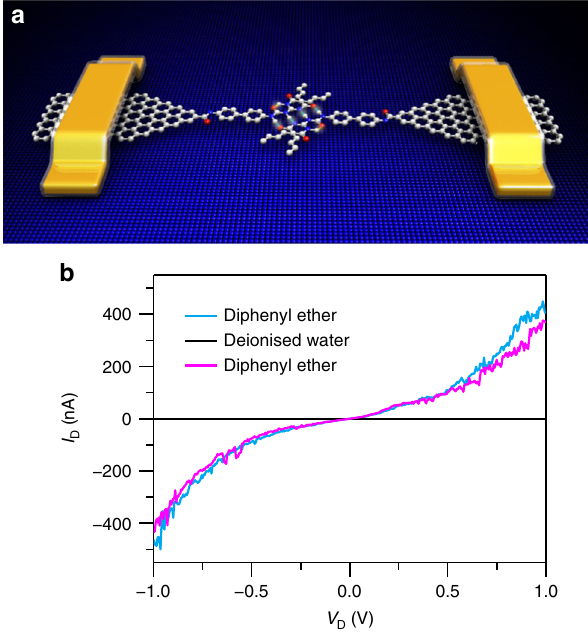
Fig. 1 Device structure and electrical characterisation of HBB-SMJs. a Schematic representation of HBB-SMJs. b I – V curves of a HBB-SMJ sequentially immersed in diphenyl ether (blue), deionised water (black)